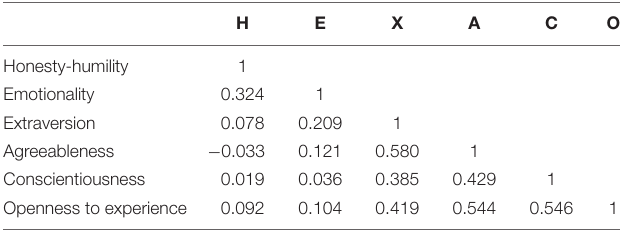
TABLE 7 | Correlations matrix using HEXACO 60-item English